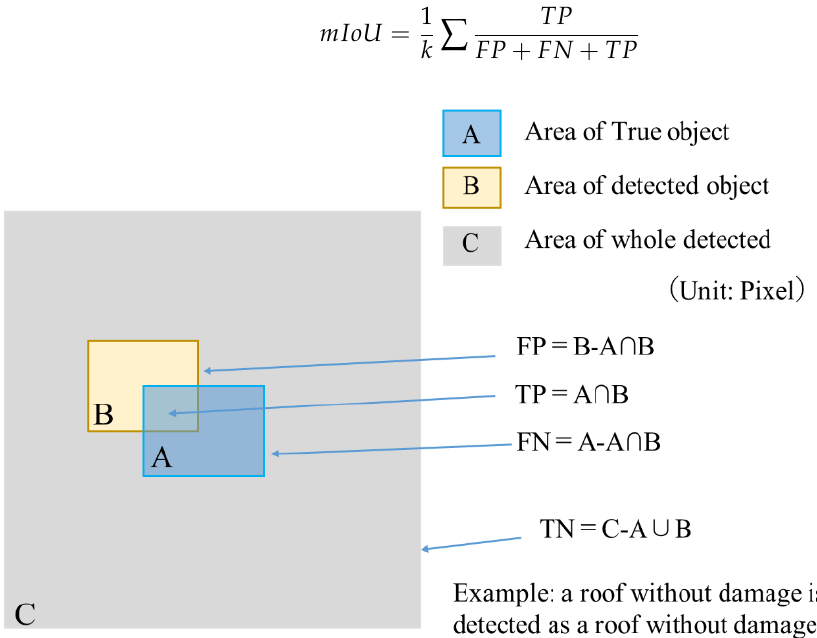
Figure 9. The calculation of TP, TN, FP, FN. Figure 10 is a result of the validation in training. According to the results of the roof outline, certain adjacent houses were mistaken for a whole object. The test result for blue tarps is the best. According to the results of roofs completely damaged, certain ships were mistakenly detected as roofs completely damaged. In the comparison between ground truth and the results of validation, it is found that the target region is accurate and satisfies the accuracy of segmentation. The mIoU of roof outline, blue tarps, and roofs completely destroyed was more than